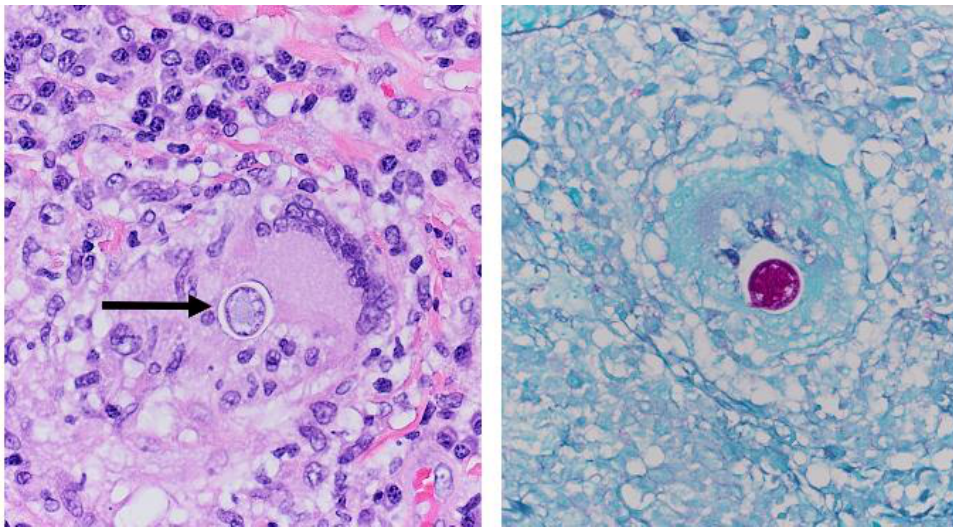
Figure 6. ( Left ): Increased magnification of Figure 5 showing multinucleated giant cell with internalized Coccidioides spherule (arrow) (H&E), 400×. ( Right ): Periodic acid-Schiff (PAS) stain for fungi showing Coccidioides spherule, 400×.